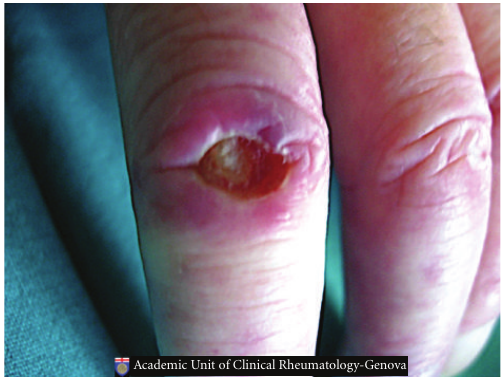
Figure 3: Classical skin digital ulcer in a patient a ff ected by systemic